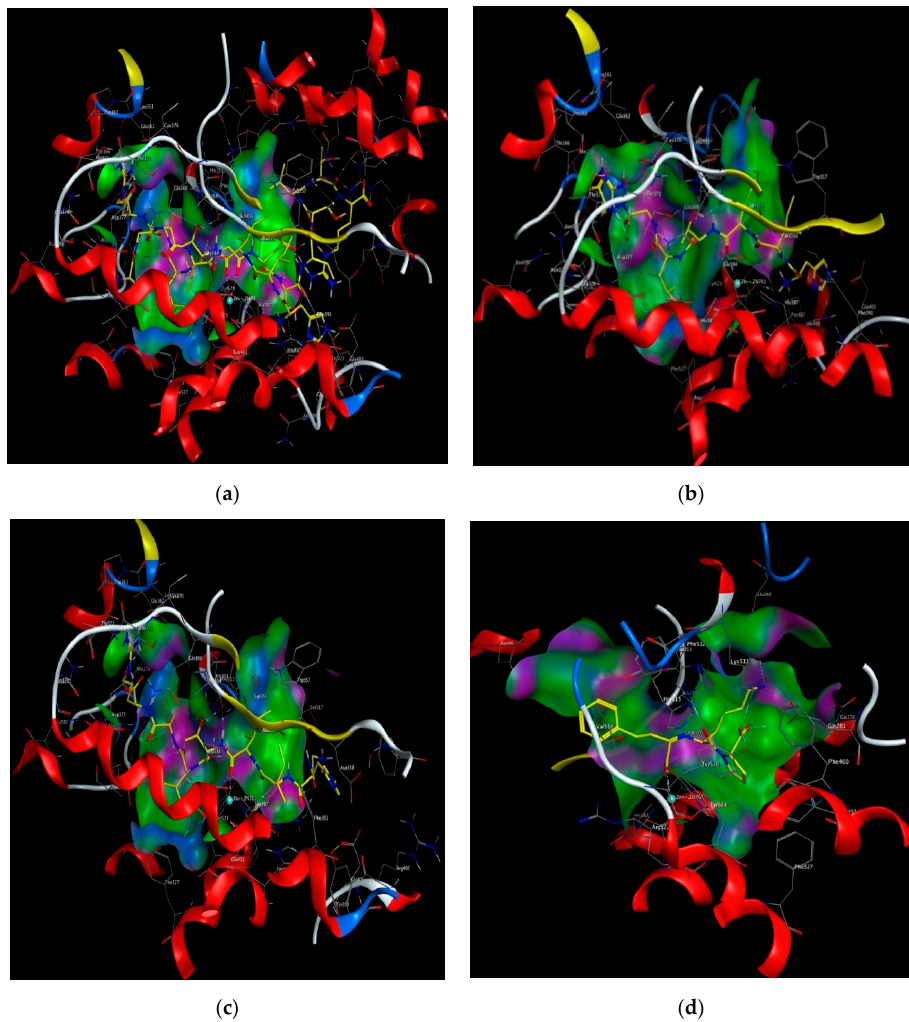
Figure 3. Computational visualization of the optimal docking conformation of AGALGDSVTVTR ( a ), HIITLGR ( b ), GHIITVAR ( c ), and lisinopril ( d ) with the active site of ACE. Carbon is in yellow, hydrogen is in grey, nitrogen is in dark blue, and oxygen is in red. The dotted lines represent hydrogen bonds.